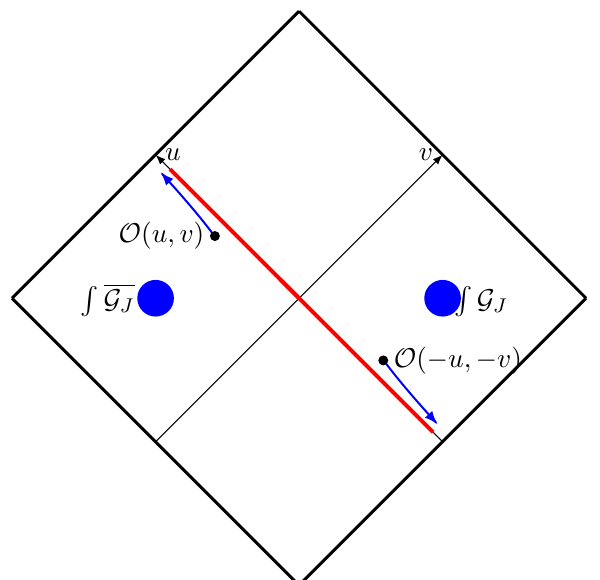
’s can be smeared G J